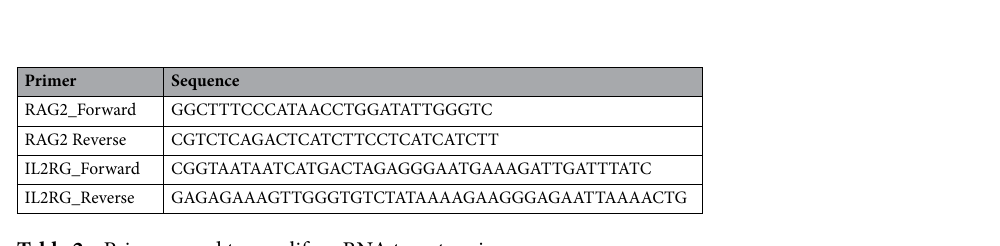
Table 1. The injected embryos were moved to culture media supplemented with 10 ng ml −1 GM-CSF and incu- bated at 38.5 °C, 5% CO 2 , and 5% O 2 until embryo transfer 54 . The cultured embryos were transferred into a surrogate gilt at day 4 post-IVF by surgically transferring into the oviduct. Pregnancy was determined by ultra- sound at around day 30 of gestation. To genotype the mutations generated by CRISPR/Cas9 system, genomic DNA was isolated from tail-tips of the newborn piglets using PureLink Genomic DNA kit (Thermo Fisher Scien- tific) following the manufacturer’s instructions. Primers flanking projected double strand break (DSB) sites were designed to amplify target region of RAG2 and IL2RG genes (Table 2). The target regions were PCR amplified using Dream Taq DNA Polymerase (Thermo Fisher Scientific). PCR conditions were as follows: initial denature at 95 °C for 2 min; denature at 95 °C for 30 s, annealing at 60 °C for 30 s, and extension at 72 °C for 30 s for 34 cycles; 72 °C for 5 min; and holding at 4 °C. The PCR amplicons were sequenced to determine the mutation types generated by the CRISPR/Cas9 system. Immunocompromised state was verified with flow cytometry to analyze the presence B (CD79A), T (CD3E), and NK (CD3E-/CD56 +) cells. Animal care. Six pigs (n total = 5 males and n total = 1 female; n = 2 male and n = 1 female used for the current study) were delivered through a sterile hysterectomy process previously described by a board-certified large animal veterinarian 55 . Pigs were monitored regularly until fully recovered from anesthesia and able to eat inde- pendently. Tail snips were taken from each piglet while still under the influence of anesthesia for genotyping, and ears were clipped for numbering. The pigs were born into sterile, gnotobiotic isolators and were fed sterile boxed milk throughout the study in order to prevent infections 55 . All animal experiments were approved and carried out in accordance with the Virginia Tech Institutional Animal Care and Use Committee under IACUC protocol: 19-117-CVM. Tumor injection and monitoring.